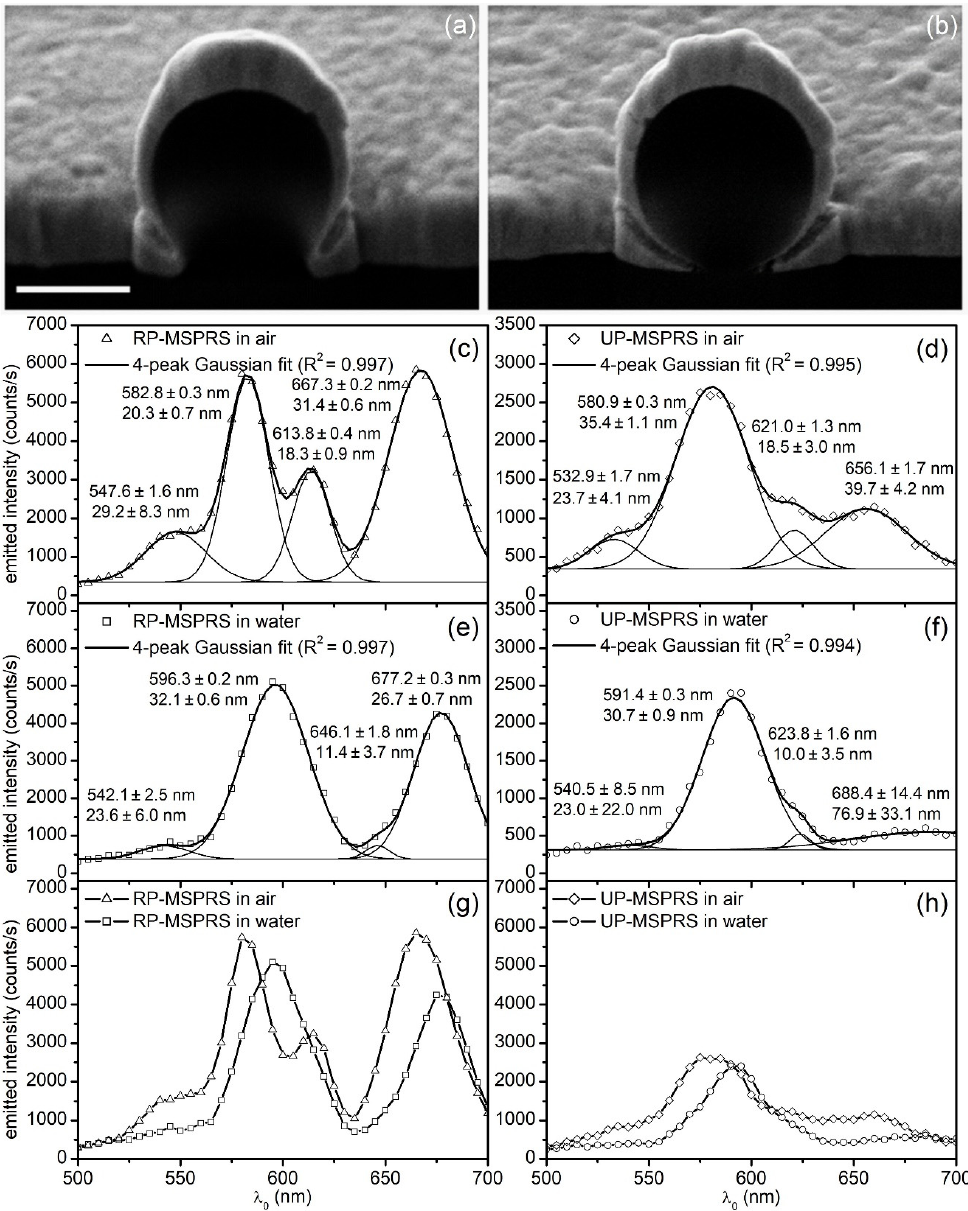
Figure 8. Scanning electron micrographs of vertical bisecting cross-sections of an RP-MSPRS ( a ) and an un-resolved peaks (UP)-MSPRS ( b ); Micrographs were corrected for 54° vertical tilt. Scale bar: 500 nm [36] ; ( c–f ) MSPRS resonances ( symbols ), with associated Gaussian peak analysis ( thin lines ), and global best fit ( thick lines ) produced in air ( c,d ) and in water ( e,f ) by an RP-MSPRS ( c,e ) and UP-MSPRSs ( d,f ) are presented. Their mean wavelengths, peak widths, and standard deviations were included; ( g,h ) to facilitate visual comparison of the spectral and intensity shifts as the refractive index chanced, the MSPRS resonances from ( c,f ) were graphed at scale with interconnected data points. From Figure 8b we found that the UP-MSPRS had a dielectric core diameter of A UP – MSPRS = 800 ± 29 nm, an underlying aperture diameter of C UP – MSPRS = 204 ± 16 nm, a resonator length measured along the vertical meridian of G UP – MSPRS = 2895 ± 58 nm, a wedged gap with a length (cid:27) 24 nm at the deep end of the of J UP – MSPRS = 399 ± 30 nm, and a variable width from E min UP – MSPRS (cid:27) 64 nm at the level of the flat Au-surface. The UP-MSPRS spectrum showed three gap to E max RP – MSPRS MSPRS resonances in air with intensities of I UP – MSPRS 0, II ,